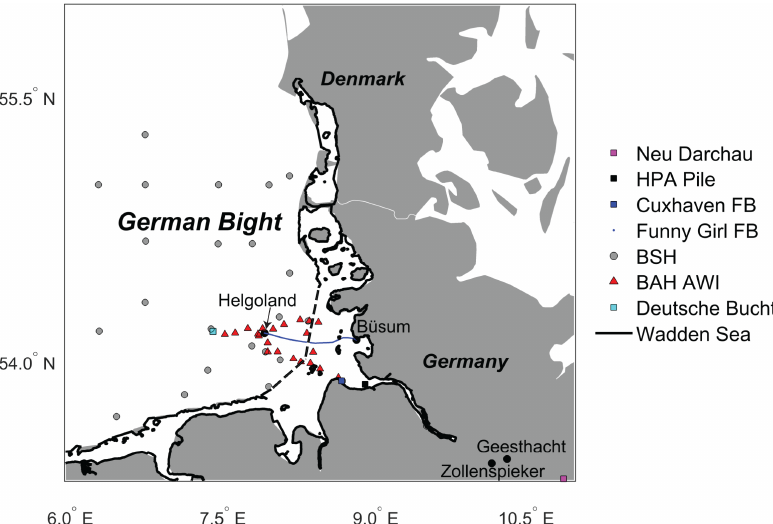
Figure 1. Map of German Bight, Elbe estuary, Wadden Sea and the continental regions around them. Stations are indicated with different symbols: Neu Darchau discharge gauging station (magenta square), operated by the German Federal Waterways and Shipping Administration (WSV); HPA pile (black square), operated by Bundesamt für Seeschifffahrt und Hydrographie (BSH) and Helmholtz-Zentrum Geesthacht (HZG); Cuxhaven FerryBox (FB, blue square), operated by HZG; M/V Funny Girl FB transect (blue line) between Büsum and Helgoland, operated by HZG; BSH discrete sampling stations (grey circles); Biological Station Helgoland at the Alfred Wegener Institute (BAH AWI) discrete sampling stations (red triangles); Deutsche Bucht MARNET monitoring station, operated by BSH (cyan square). The Wadden Sea outline was obtained as a shape file from Claus et al. (2016), and the dashed line represents the imaginary boundary of the shapefile rather than the Wadden